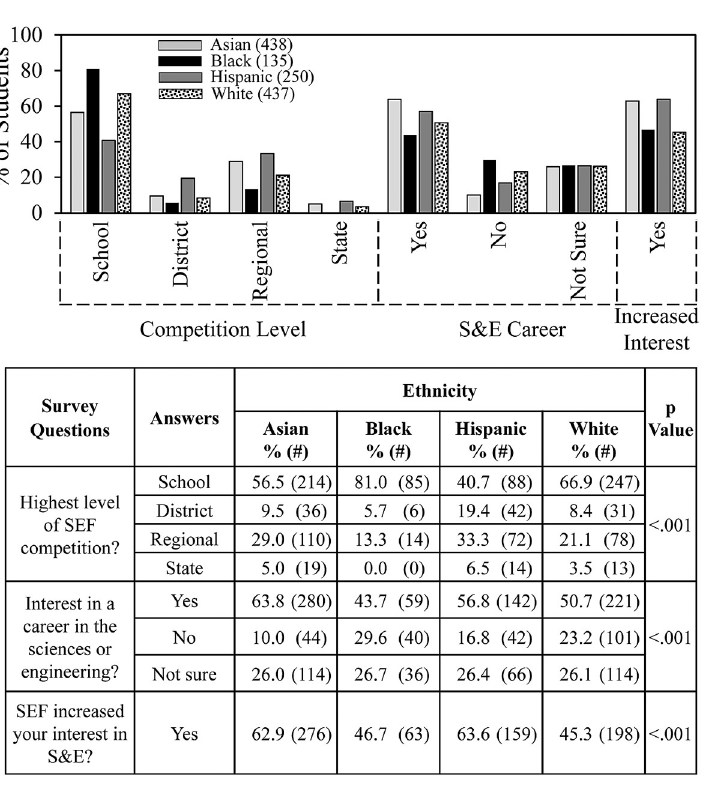
Fig 4. Ethnicity and SEF